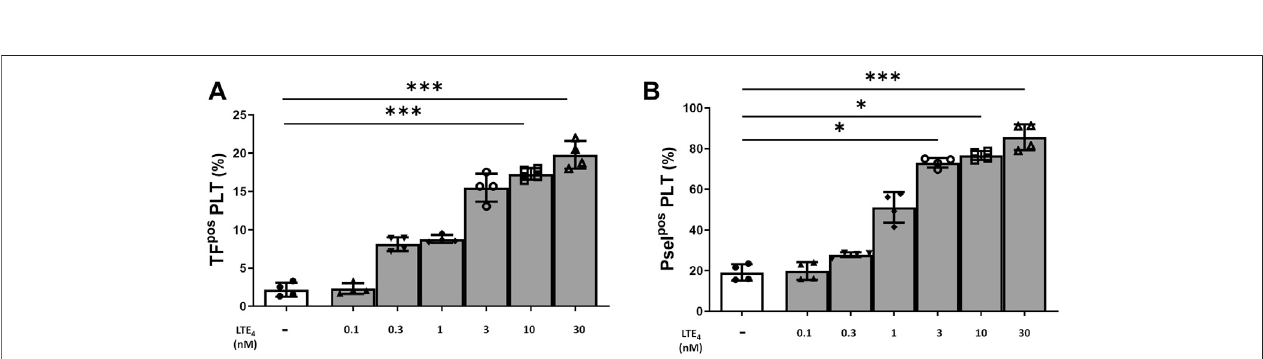
FIGURE 4 | In vitro effect of LTE 4 on platelet-associated tissue factor (A) and P-selectin (B) expression. Whole blood was stimulated with LTE 4 (0.1 – 30 nM), for 15 min at room temperature. The percentage of TF pos - and P-selectin pos -platelets is shown. Data are reported as mean ± SD. * p < 0.05; *** p < 0.001 (TF, tissue factor; Psel, P-selectin; PLT,